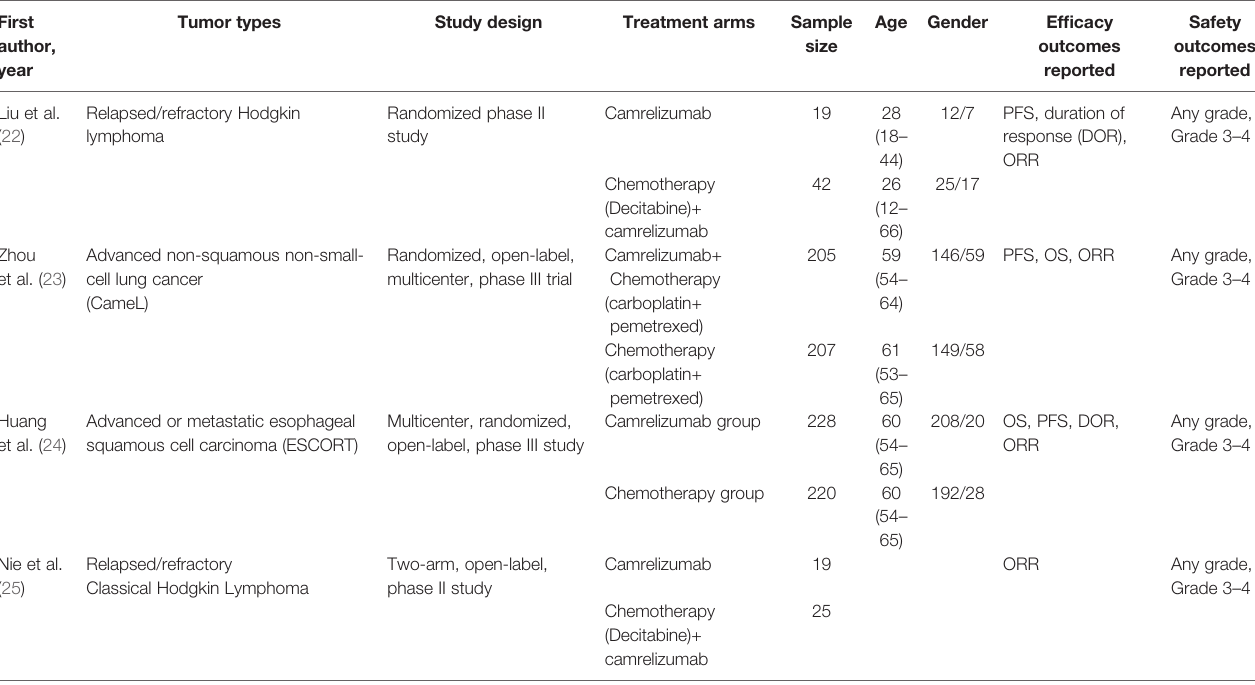
TABLE 1 | Baseline Characteristic of included